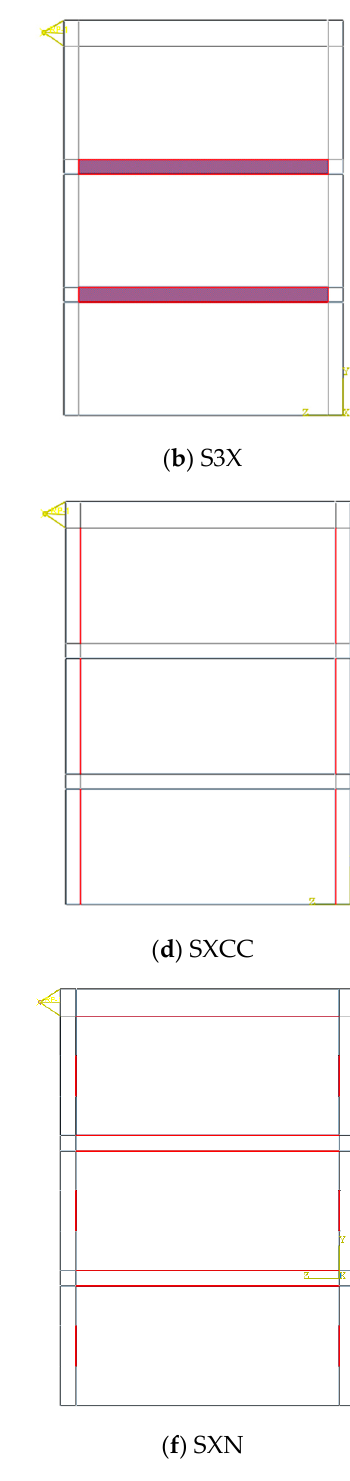
Figure 5. Changes in the boundary elements and connections of the FE models. Table 1. Models and changes in boundary elements.